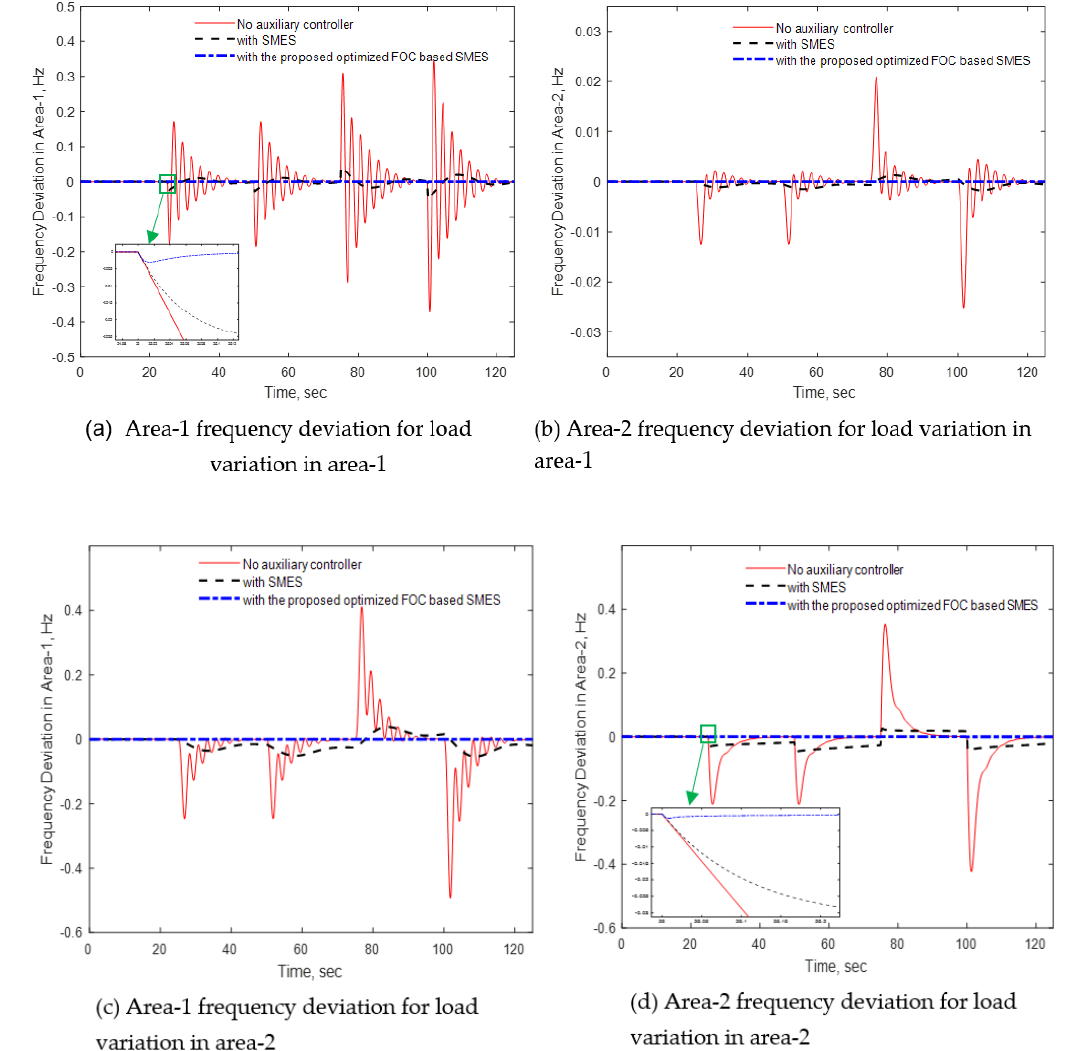
Figure 13. Frequency response for both areas under multiple load profile